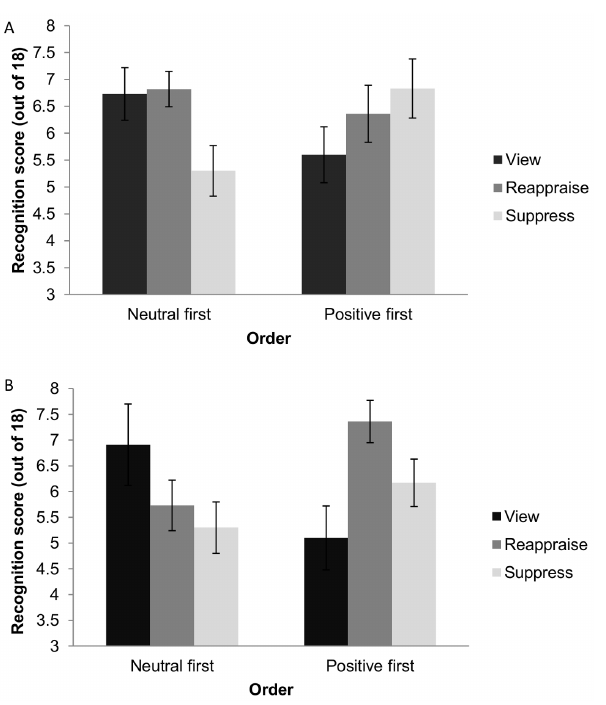
Figure 2. Non-verbal memory scores for neutral (A) and positive (B) pictures. Legend: Non-verbal memory score according to emotion regulation strategy (reappraise, suppress, or view)and order (neutral or positive pictures first); error bars represent standard error of the mean.